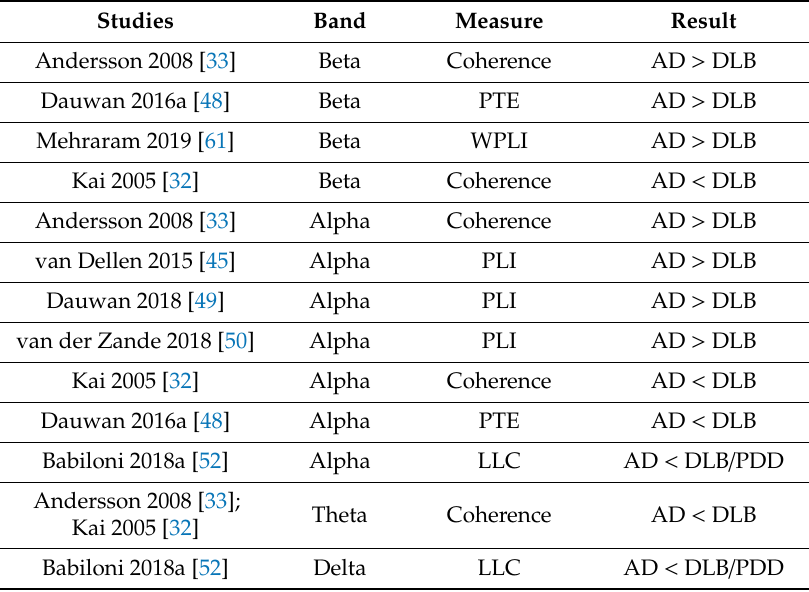
Table 3. Summary of studies on EEG connectivity measures in